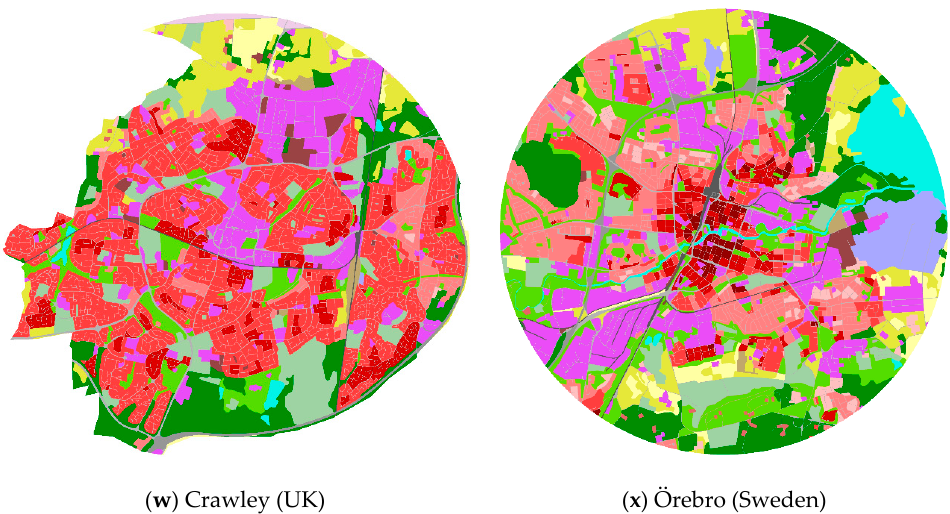
Figure A1. Pairs of similar cities according to land use produced by hierarchical clustering. ( a ) Modena (Italy); ( b ) Parma (Italy); ( c ) Perpignan (France); ( d ) Plovdiv (Bulgaria); ( e ) Basel (Switzerland); ( f ) Bielsko-Biala (Poland); ( g ) Perugia (Italy); ( h ) Plauen (Germany); ( i ) Orléans (France); ( j ) Poznaˇn (Poland); ( k ) Guimares (Portugal); ( l ) Osnabrück (Germany); ( m ) Augsburg (Germany); ( n ) Aviles (Spain); ( o ) Ljubljana (Slovenia); ( p ) Lübeck (Germany); ( q ) Enschede (Netherlands); ( r ) Oviedo (Spain); ( s ) Glogow (Poland); ( t ) Maastricht (Netherlands); ( u ) Č eské Bud ě jovice (Czech Republic); ( v ) Hradec Králové (Czech Republic); ( w ) Crawley (UK); ( x ) Örebro (Sweden).